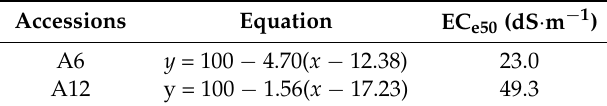
Table 3. Mass and Hoffman model used for relative survival of two accessions used for experiment evaluated on EC e50 .